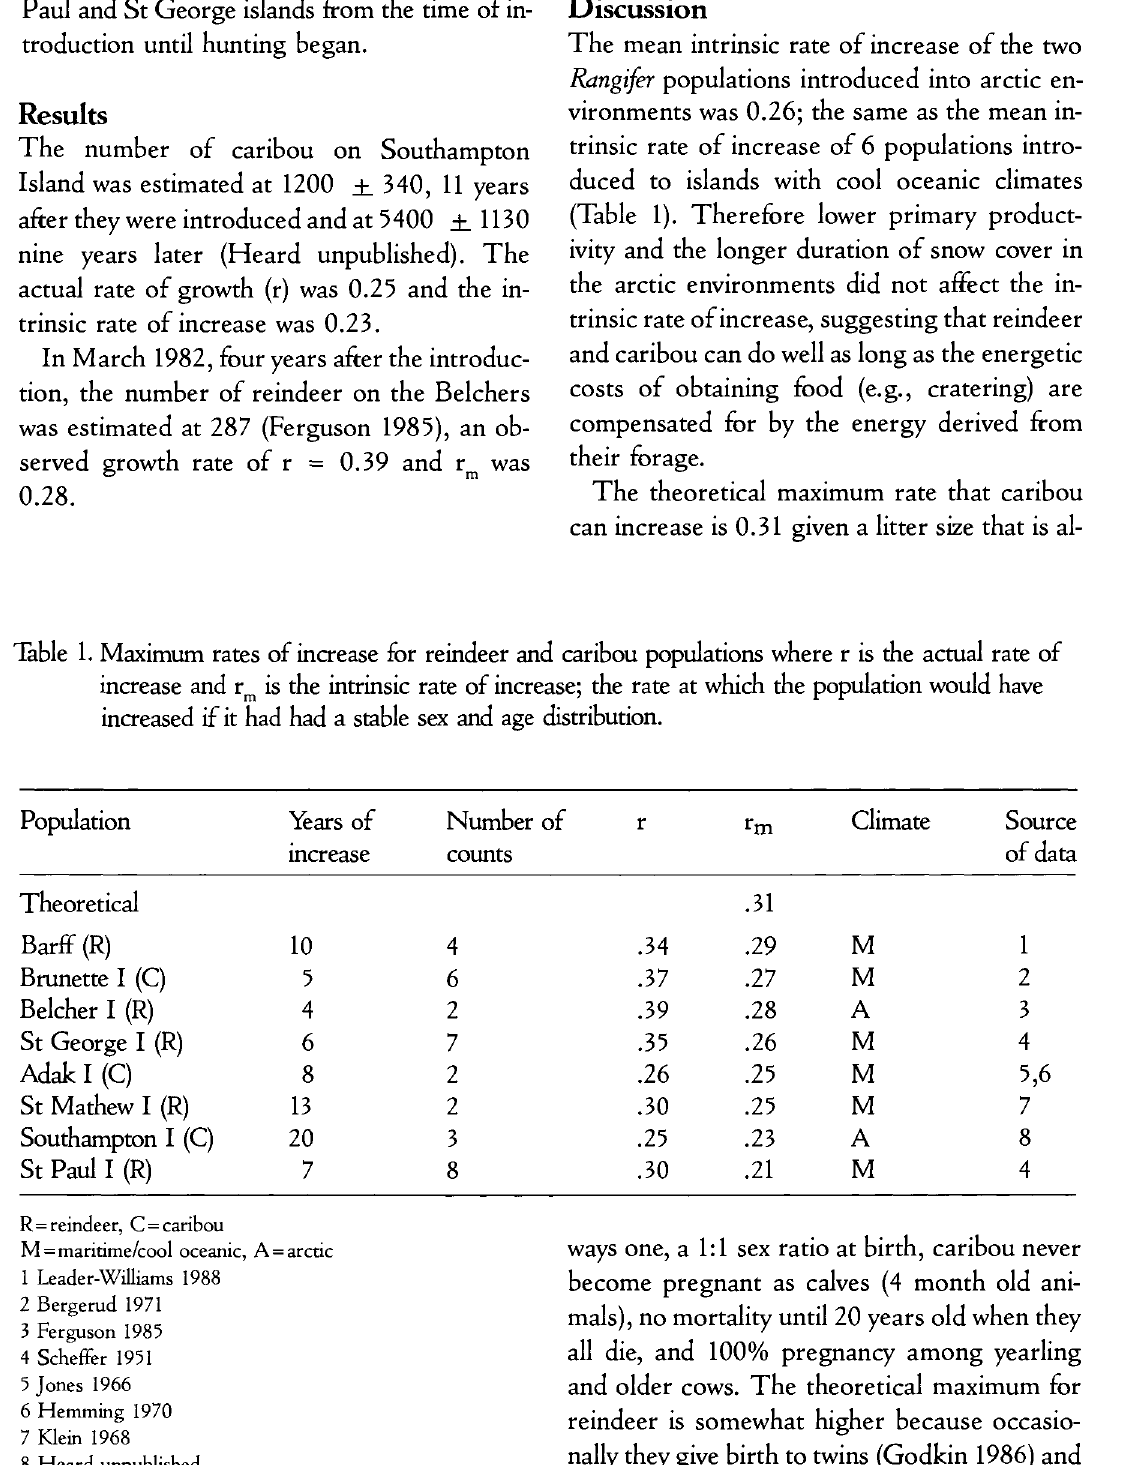
Table 1. Maximum rates of increase for reindeer and caribou populations where r is the actual rate of increase and r is the intrinsic rate of increase; the rate at which the population would have m increased if it had had a stable sex and age